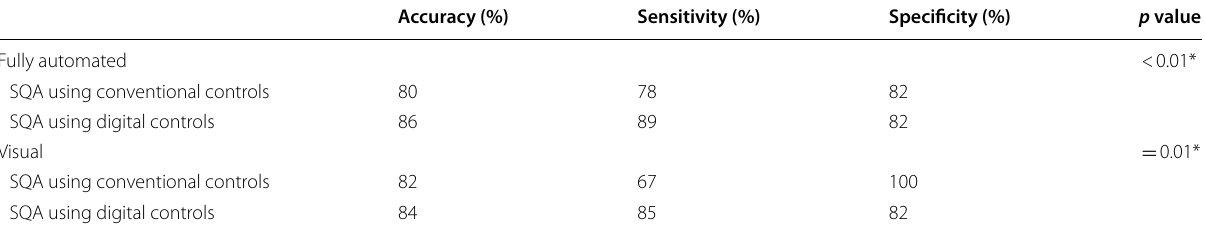
* For the comparison between SQA using conventional and digital controls